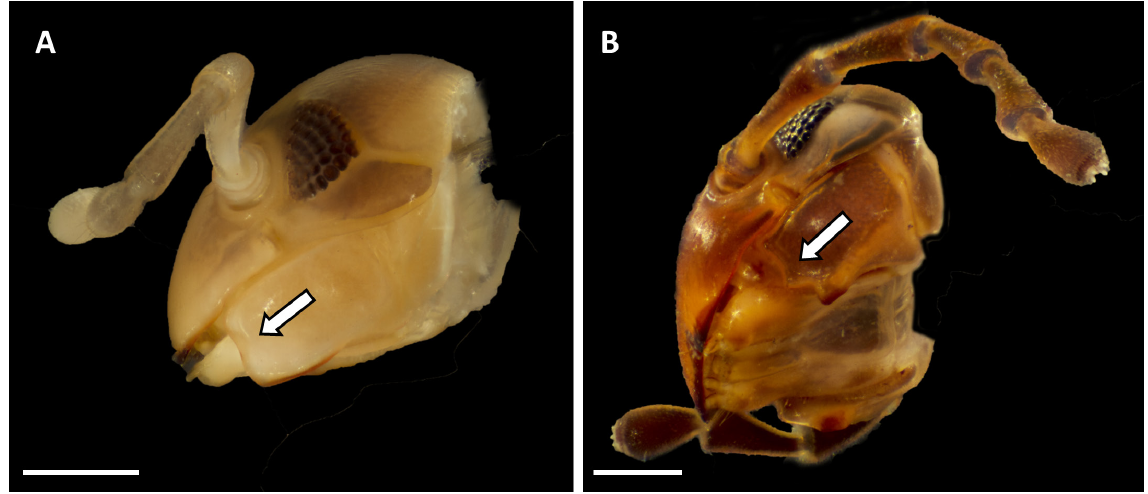
Fig. 3. Heads of odontopygid males, arrows point to distal margin of mandibular stipes. A . Spinotarsus axeli sp. nov., holotype (NHMD 621761), distal margin of stipes concave/bilobed, as in most odontopygids. B . Callistodontopyge latifolia (Attems, 1914), specimen from Kiverenge FR (NHMD 621713), distal margin of stipes trilobed as characteristic of this genus. Scale bars = 1 mm. Photo S.G.